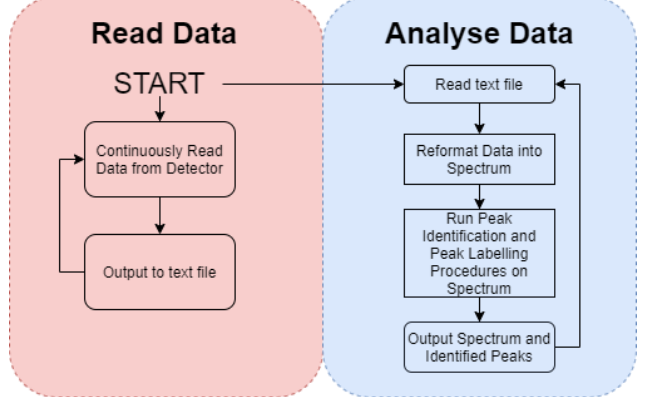
Figure 1. Flowchart of the wrapper script which simultaneously co-ordinates real-time data input and online